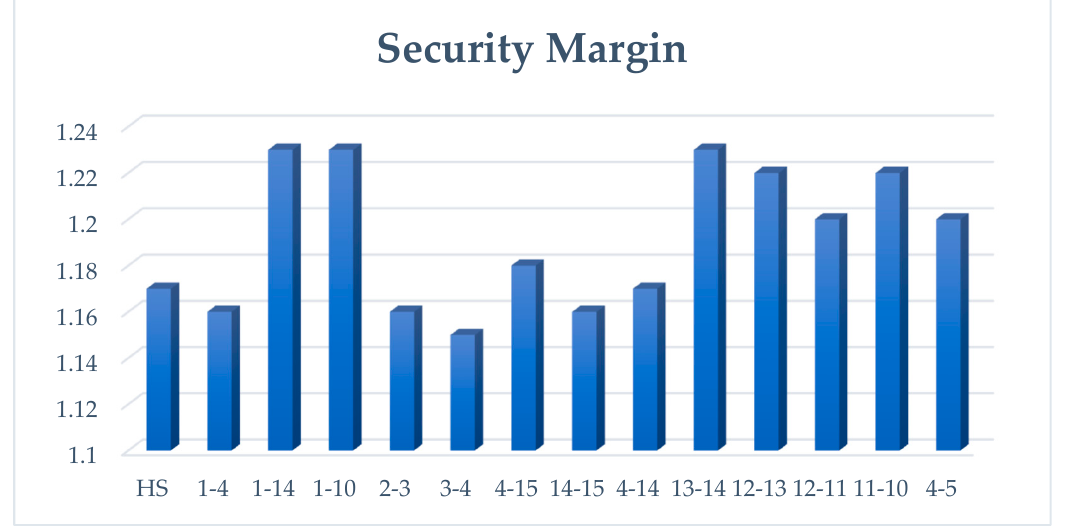
Figure 6. Security Margin of Indian 62 Bus system for various contingencies. HS = Healthy System.